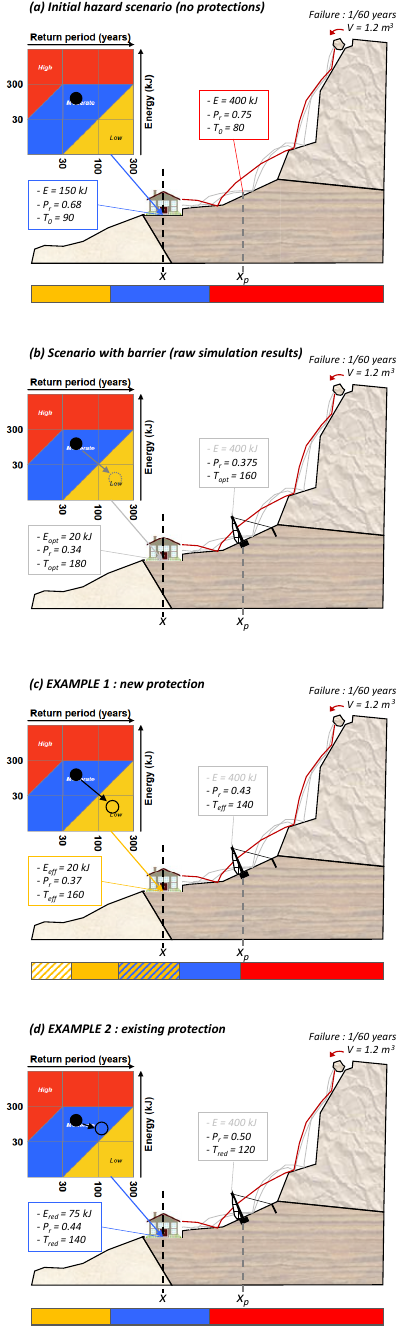
Figure 9. Example of application of the methodology. (a) Hazard scenario before protections, (b) theoretical hazard scenario obtained in the presence of the protection based on raw rockfall simulation results. (c) Methodology applied to new protections: reclassification of hazard possible. (d) Methodology applied to existing protections: reclassification of hazard not possible. Below each scheme the cor- responding hazard zoning is reported: for cases (c) and (d) this is obtained by applying the methodology to every abscissa beyond the rockfall